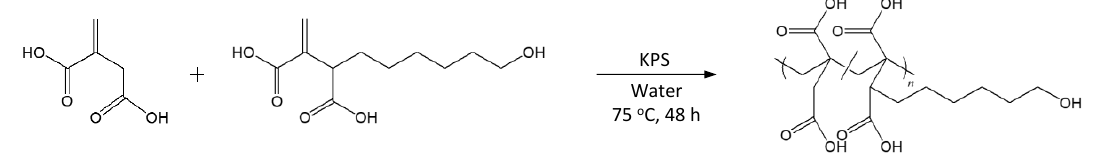
Figure 1. Synthesis of poly(IA- co -10-HHIA)s.